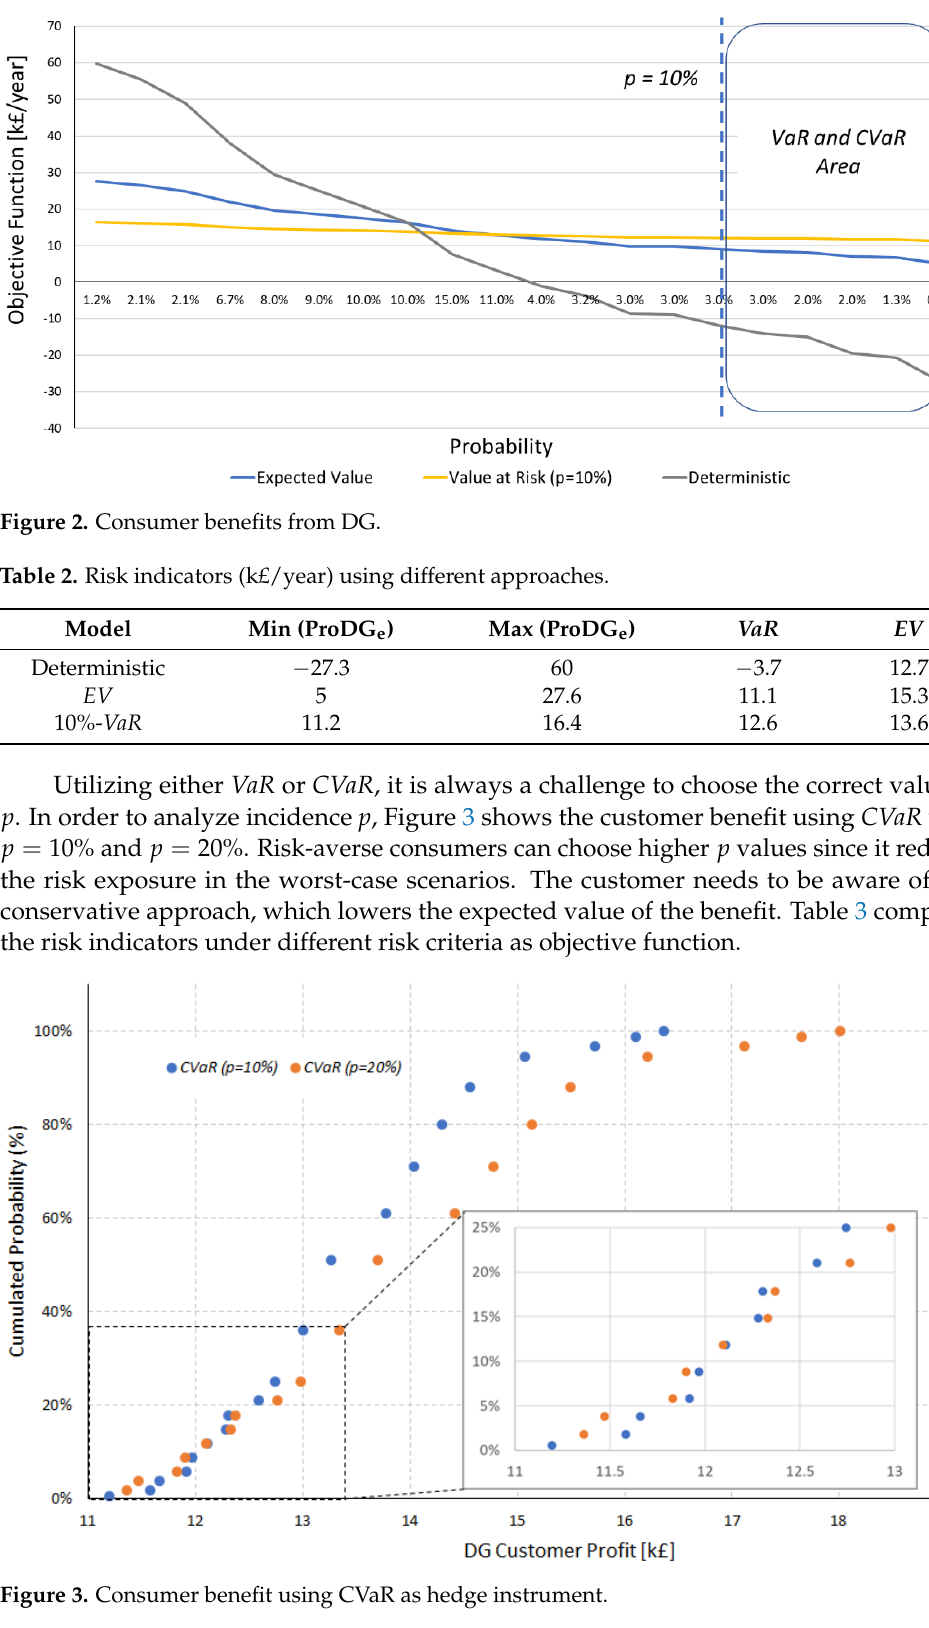
0.9 Figure 4. Probability distribution of study cases.